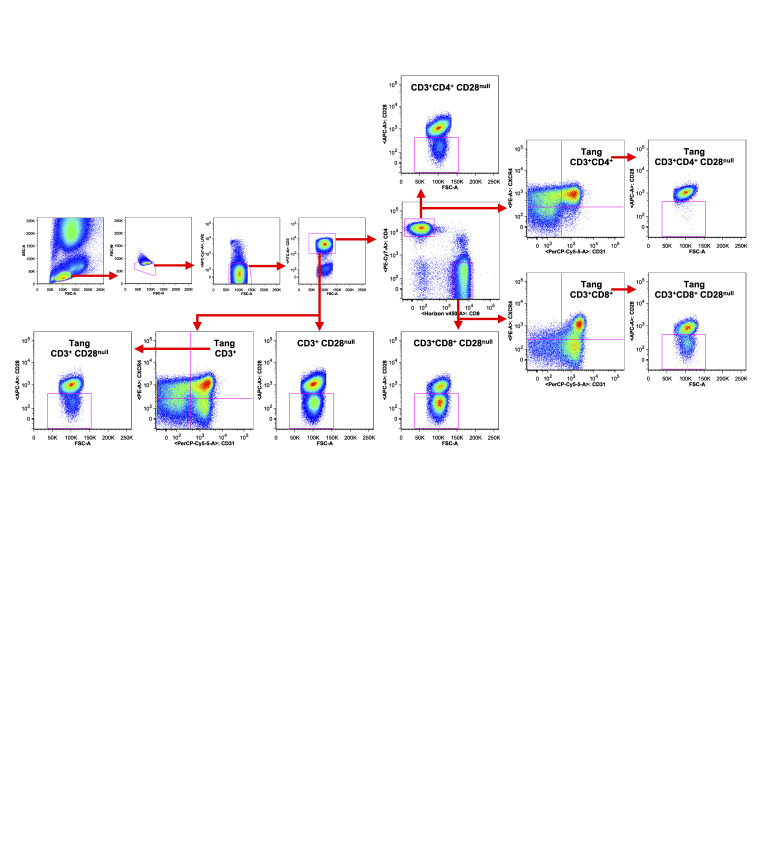
Gating strategy used to characterize T cell subpopulations. WBCs isolated from one representative SLE patient were analyzed by flow cytometry. Representative gating strategy analysis is shown. The axis scales for fluorescence are reported as log; the axis scales for SSC, FSC are reported as linear.